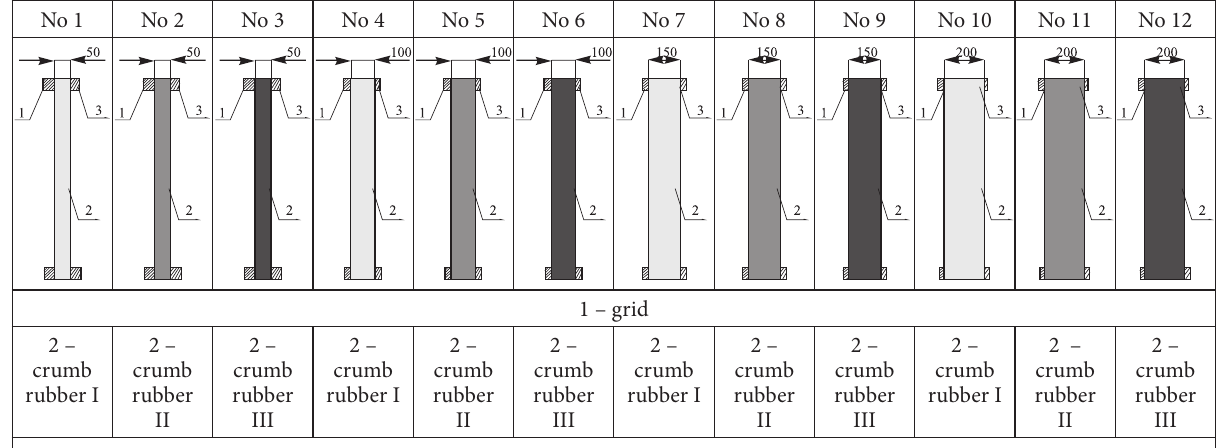
Table 1. Samples of the experimental